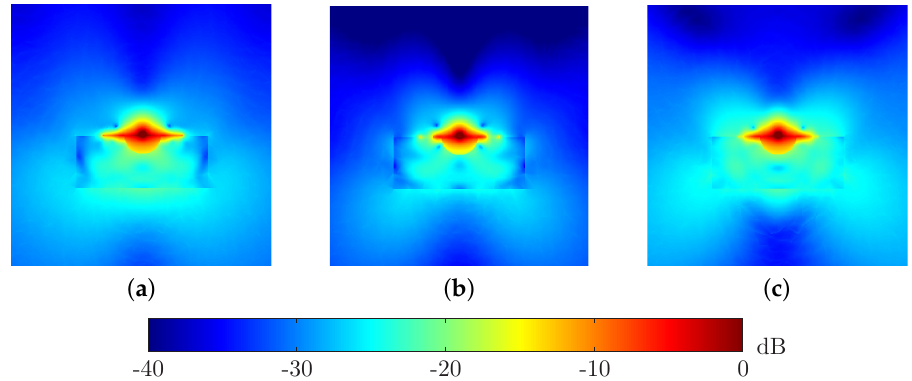
Figure 10. Distribution of the electric field amplitude at xy − plane for ( a ) µ c ,out = 0.1eV, ( b ) µ c ,out = 0.5eV, and ( c ) graded increment of matching component’s chemical potential.